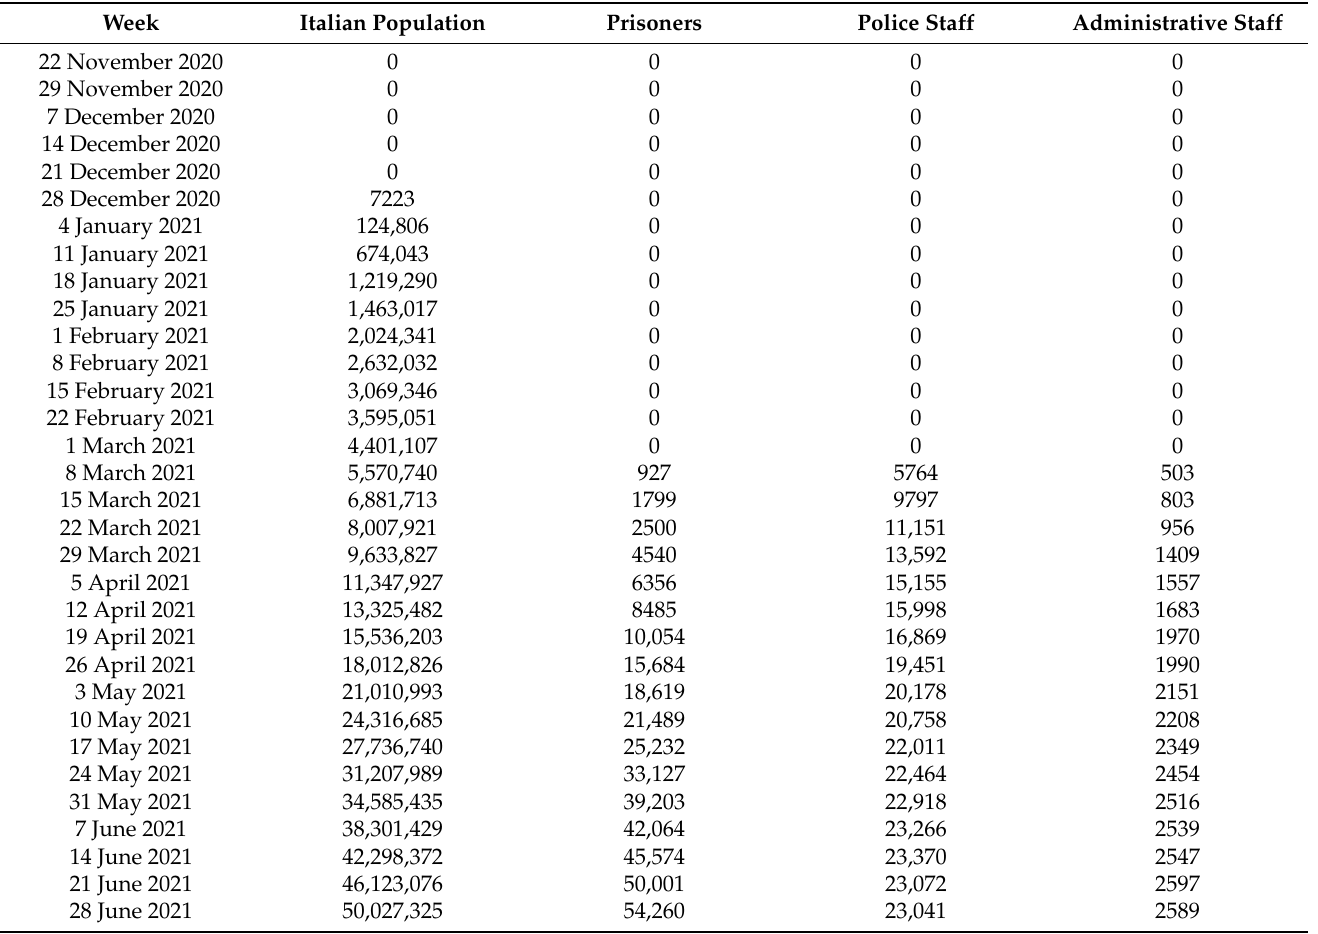
Table 3. Vaccine doses administered among Italian population, prisoners, and prison